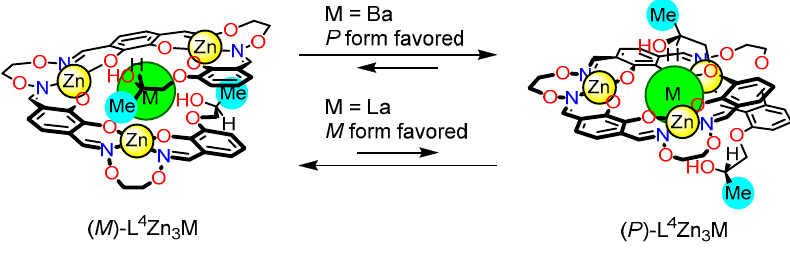
Figure 12. Dynamic equilibrium between P and M forms of tetranuclear complex L 4 Zn 3 M that has tris(salamo) ligand L 4 with ( S )-2-hydroxypropyl groups as the chiral auxiliary (Category A in Figure 4).